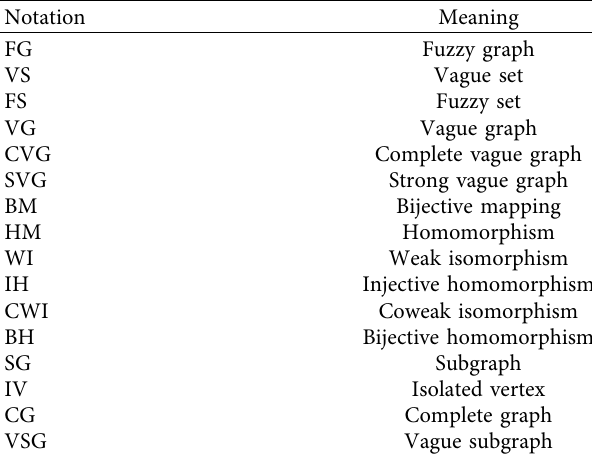
Table 1: Some basic